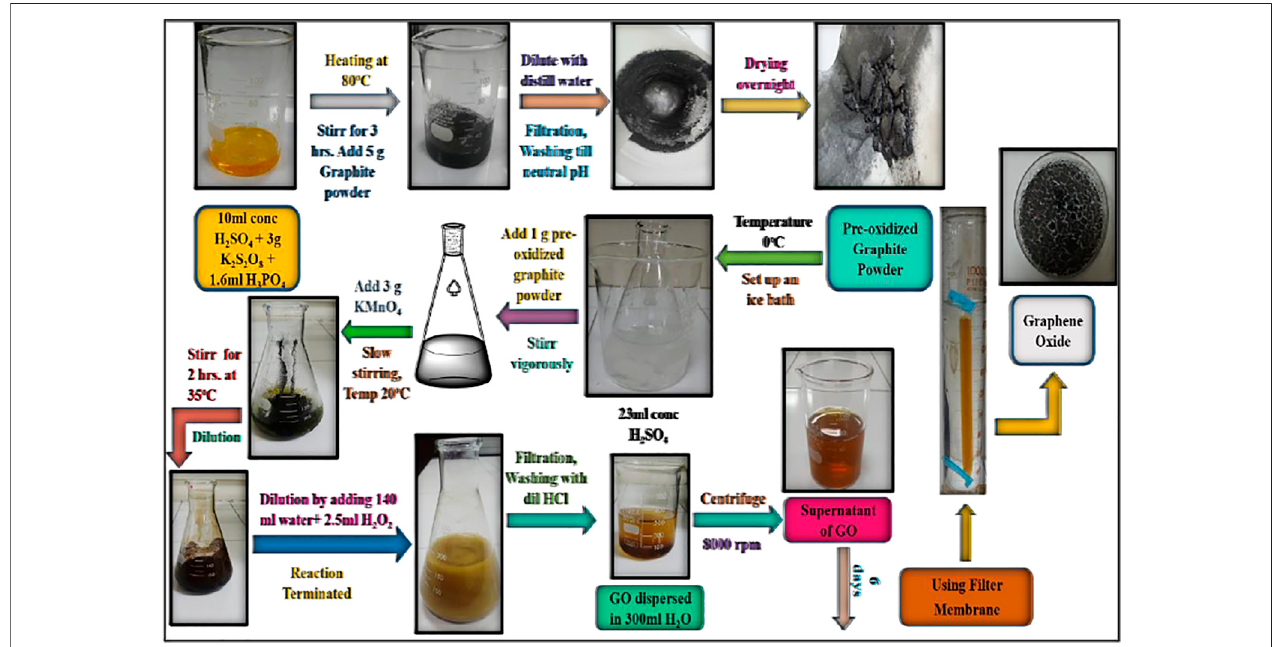
FIGURE 1 | The modi fi ed Hummers technique was used to synthesize